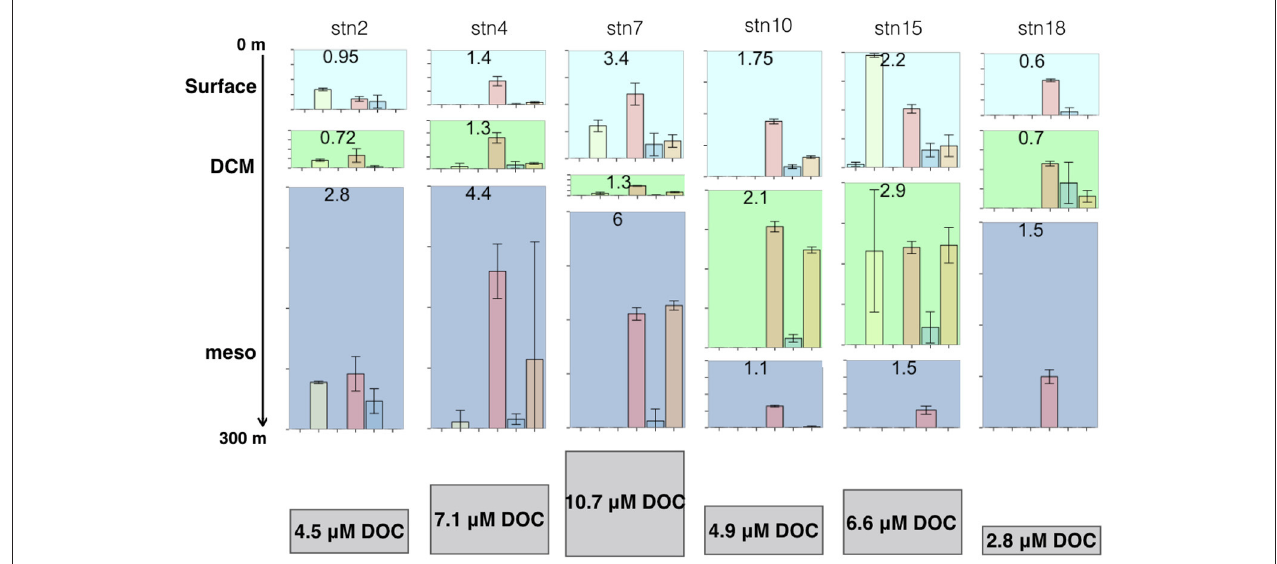
FIGURE 7 | Conceptual model of DOC generation under varying hydrolytic capacities and rates observed in this study, at each station from southernmost to northernmost (vertical panels). The amount of DOC generated, in µ M, at the surface (top), DCM (middle), and mesopelagic (bottom) is shown at the top of each panel, and varies according to the relative hydrolytic capacities and rates, and the degree of stratification at that site. The total amount of DOC generated throughout the upper water column is shown below each station, and varies by station.